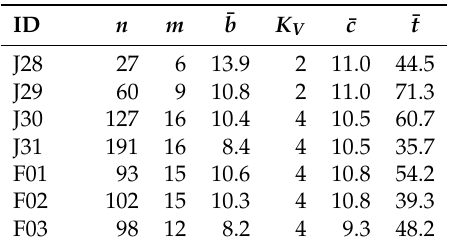
Table 2. Summary of the basic characteristics of the seven real-world instances. ¯ b : average number of individuals per area; K V : number of types of vehicles; ¯ c : the average capacity of vehicles; ¯ t : average travel time between two areas (in